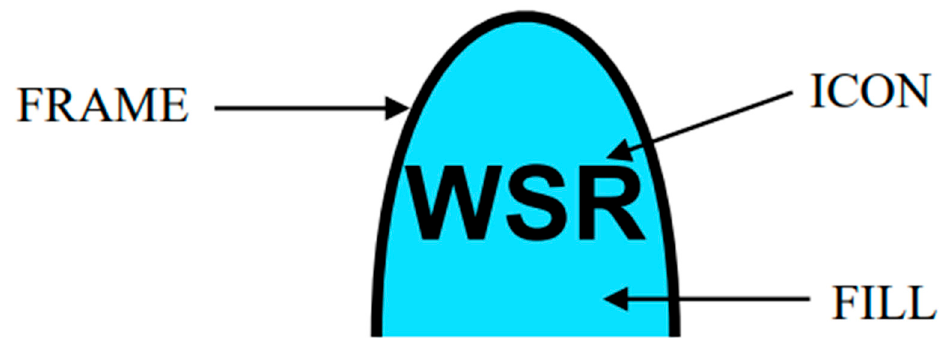
Figure 2. Cyberspace Symbol Components.